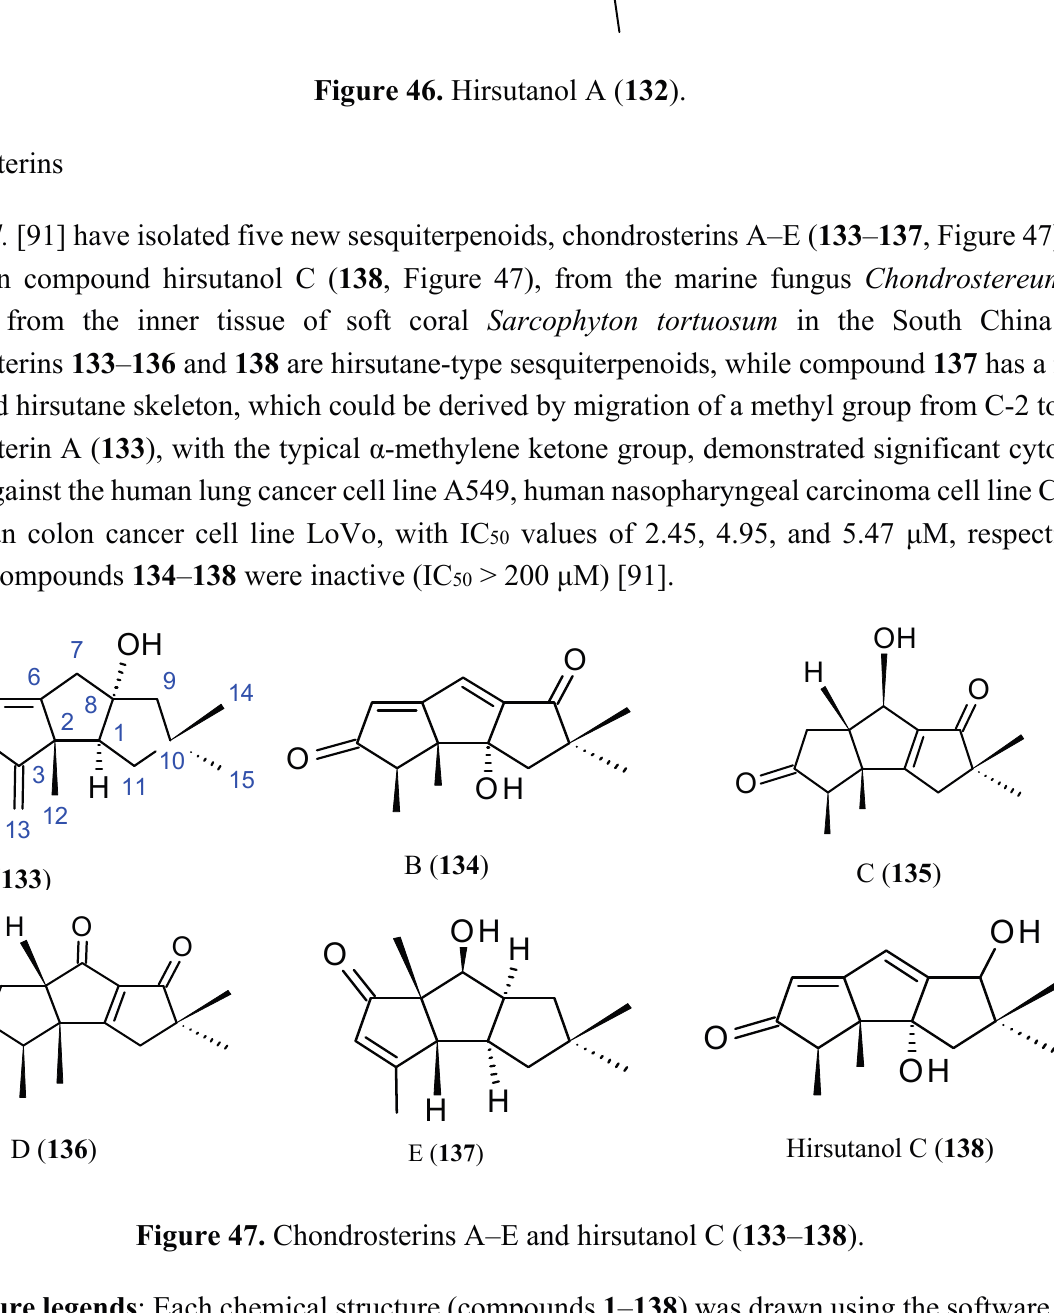
Figure legends : Each chemical structure (compounds 1 – 138 ) was drawn using the software ChemBioDraw Ultra, version 12.0.3.1216 (Cambridge Soft Corporation, Cambridge, MA, USA) and is in conformity with the original structures published in the literature. In some cases, if the pharmacophores are known, they are highlighted in the form of blue